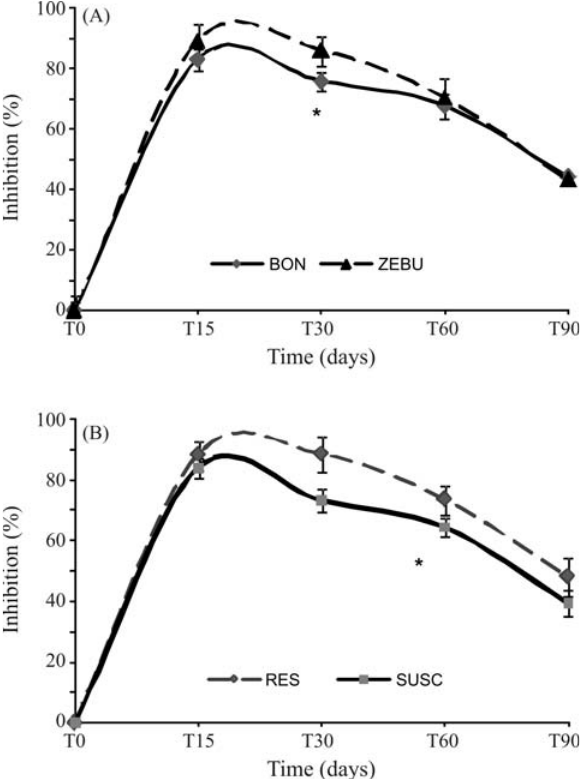
Figure 1 - Influence of breed (A) and susceptibility to infection (B) on the anti- B. abortus antibody titers in sera of experimentally infected animals. The points are the mean (cid:2) SD of IP (Inhibition Percentage), R = resistant, S = susceptible. The curves in panel A contain the combined results for re- sistant and susceptible animals for each breed, and whether the curves for resistant and susceptible animals in the right-hand panel contain both BON and Zebu animals.